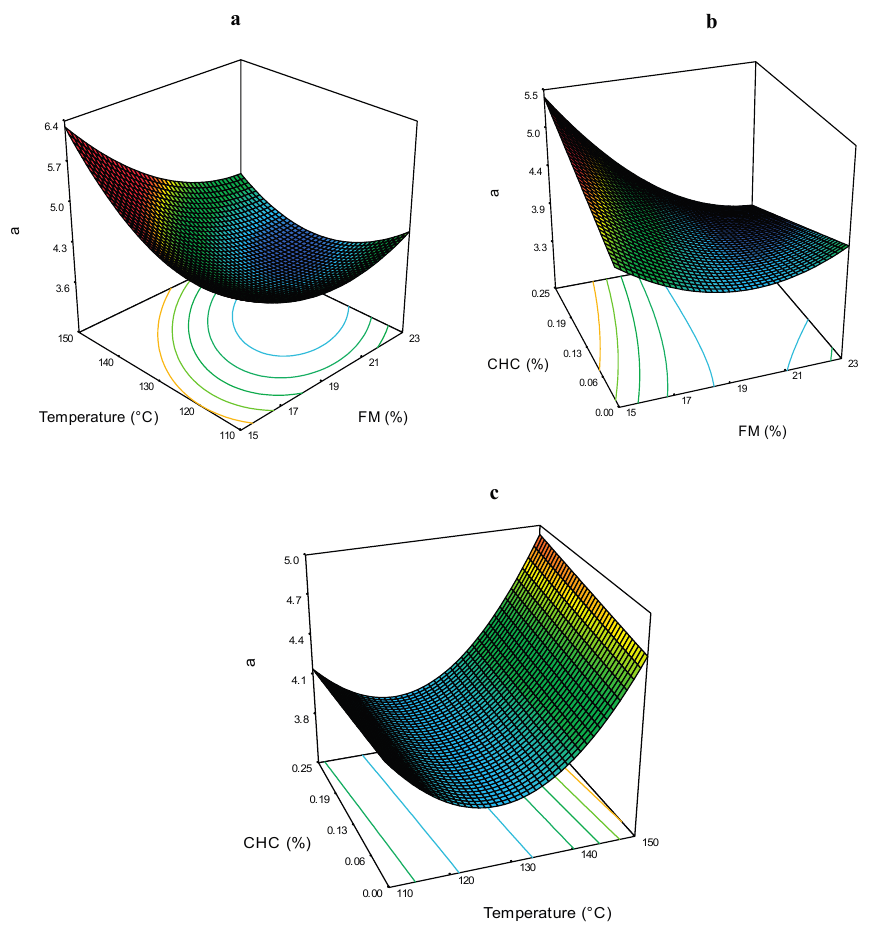
Figure 4 . Color parameter a of expanded nixtamalized blue corn extrudates, as a function of: ( a ) feed moisture (FM) and temperature (T); ( b ) feed moisture (FM) and calcium hydroxide concentration (CHC); and ( c ) temperature (T) and calcium hydroxide concentration